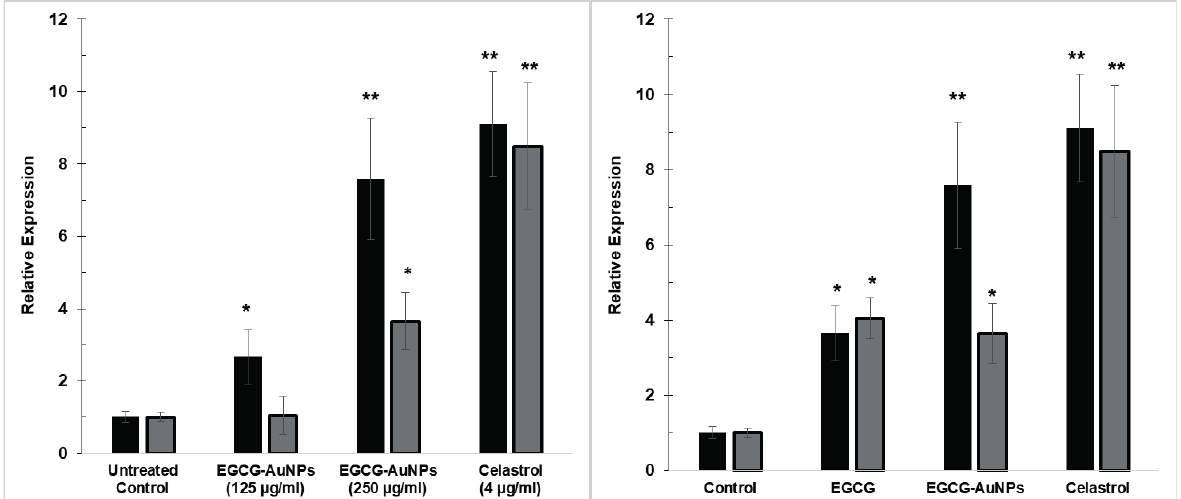
Figure 4. a. Relative expression of let-7a (black bars) and miR-34a (gray bars) in HepG2 cells, after treatment with EGCG-AuNPs and celastrol. b . c-Myc protein levels in HepG2 cell lysates, expressed as OD/mg protein/ml, after treatment with EGCG-AuNPs and celastrol, for 72 h, compared with untreated control. Data are presented as the mean ± SD (n = 6). Statistical analysis was performed using Graphpad Prism V6.01. *p < 0.05 and ** P < 0.001 compared with the corresponding